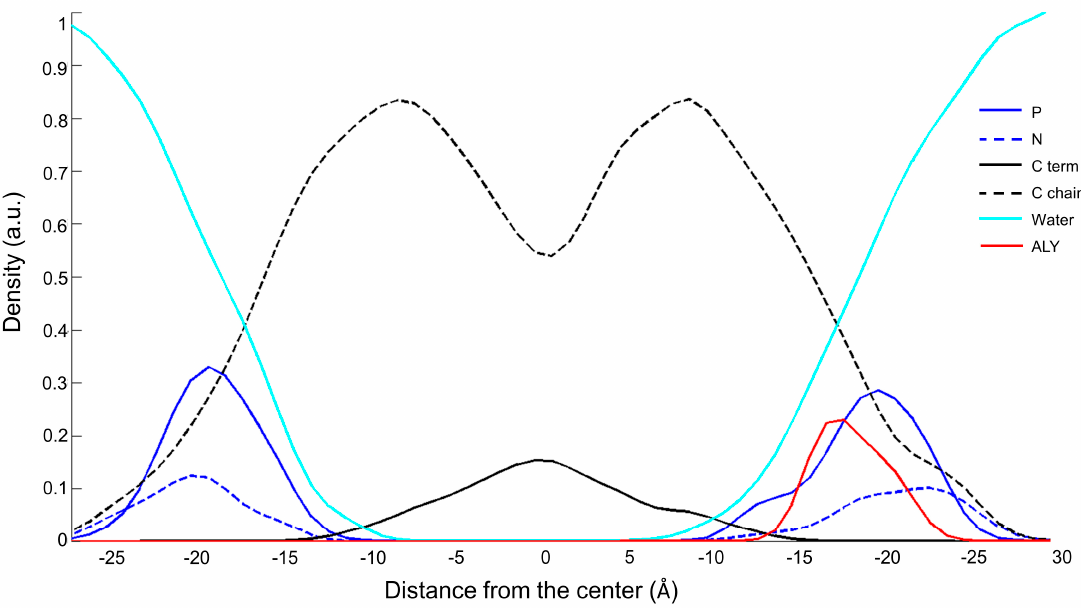
Figure 1. Density profile of the system ALY-POPC / POPG (9:1) after 45 ns of molecular dynamic (MD) simulation. Cyan line: water molecules; blue line: phosphorous atoms; dashed blue line: nitrogen atoms; dashed black line: carbon chains of the phospholipid, black line: terminal carbons of the phospholipid; red line ALY peptide.